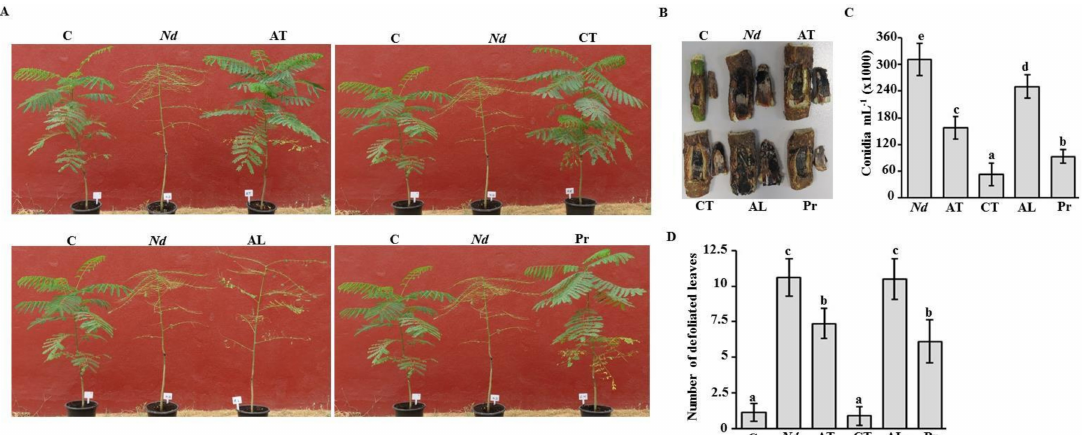
Figure 7. E ff ect of fungicide treatments on artificially inoculated royal poinciana seedlings with Neoscytalidium dimidiatum in the greenhouse. Fungicidal suppression of stem canker disease on royal poinciana seedlings using ( A ) potential chemical fungicides; ( B ) symptoms of inoculated regions; ( C ) number of conidia after recovery of the pathogen from stem tissues; and ( D ) number of defoliated leaves in inoculated seedlings sprayed with chemical fungicides at 4 wpt. In ( A–D ), seedlings were inoculated for 2 weeks with N. dimidiatum before the fungicide treatment. In ( C & D ), mean values with di ff erent letters are significantly di ff erent from each other at p < 0.05. Experiments were repeated at least three times with similar results. C, control (no N. dimidiatum ); Nd , N. dimidiatum ; AT,